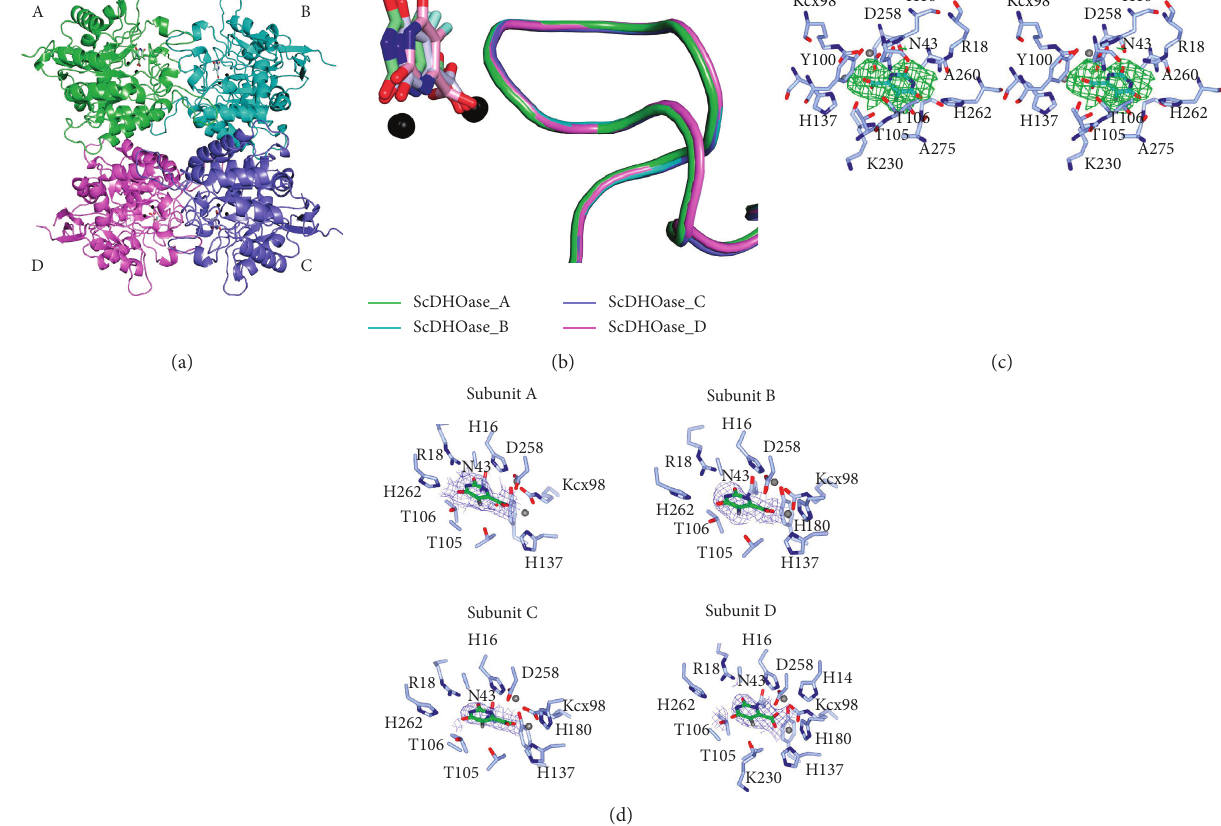
Figure 2: Structure of ScDHOase complexed with 5-FOA. (a) Ribbon diagram of the ScDHOase-5-FOA complex tetramer. Each monomer is color-coded. Two zinc ions in the active site are presented as black spheres. (b) Structural comparison of the active sites in ScDHOase tetramer. The superimposed structures of these 5-FOA-bound states revealed that the flexible loop is in loop-in conformation in each subunit. (c) Stereo view of the real-space averaged OMIT | F o | − | F c | map (green mesh, contoured at 3 σ ) of 5-FOA bound to ScDHOase. The bound 5-FOA (cyan) and ScDHOase (light blue) are shown as sticks. The carboxylate group of 5-FOA ligates the Zn atoms (gray spheres). (d) The composite OMITmap (blue mesh, contoured at 1 σ ) of 5-FOA bound to ScDHOase. The bound 5-FOA (green) and ScDHOase (light blue) are shown as sticks. Two zinc atoms are shown as gray